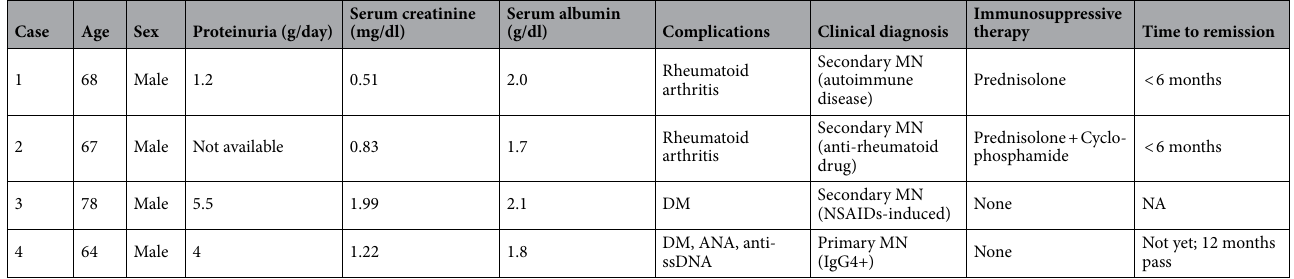
Table 3. Clinical information in each case of NELL-1–associated MN. DM diabetes mellitus, ANA antinuclear antibody, ssDNA Ab single strand DNA antibody, MN membranous nephropathy, NSAIDs nonsteroidal anti- inflammatory drugs, NA not